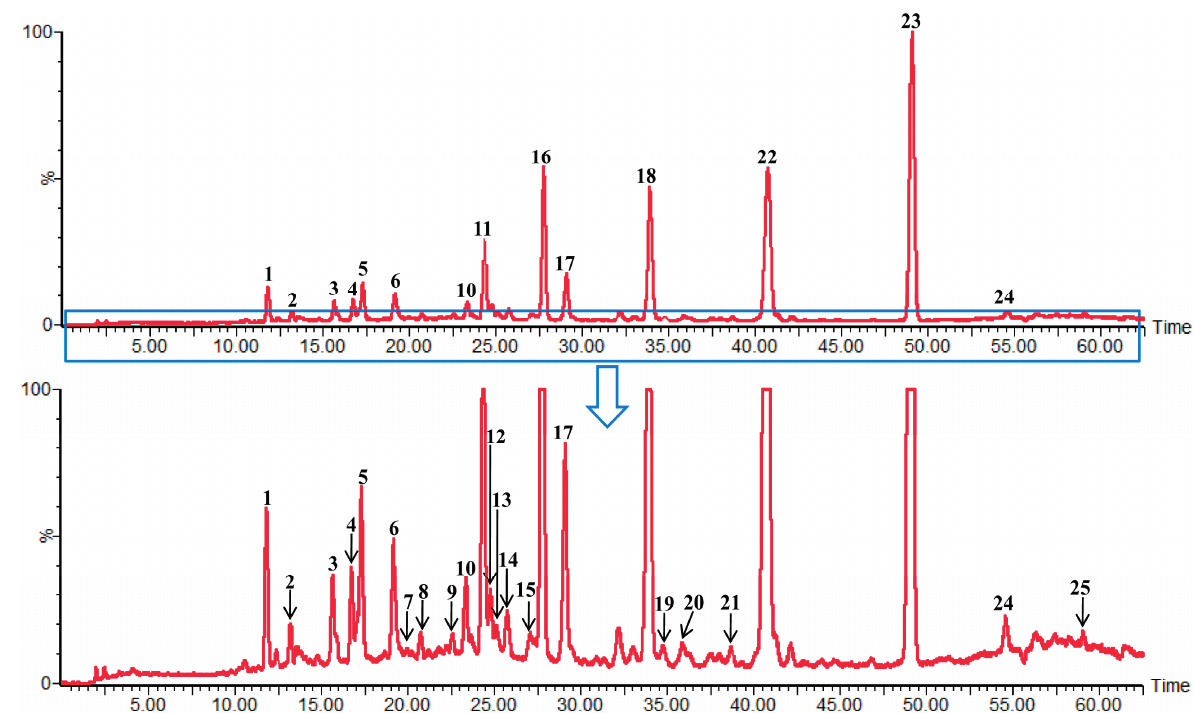
Figure 2. HPLC-DAD-Q-TOF MS total ion chromatogram of AMR in positive ion mode.